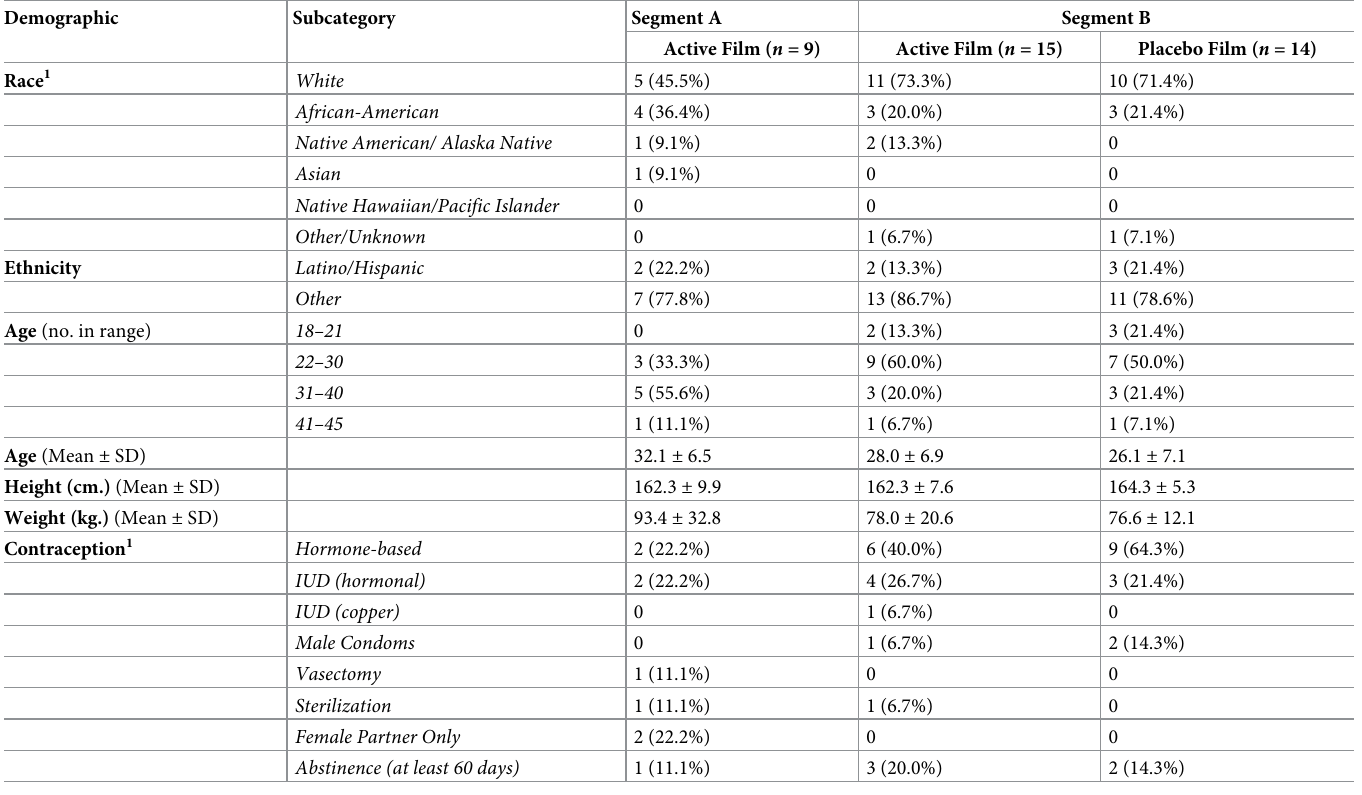
Table 1. Summary of baseline characteristics of enrolled